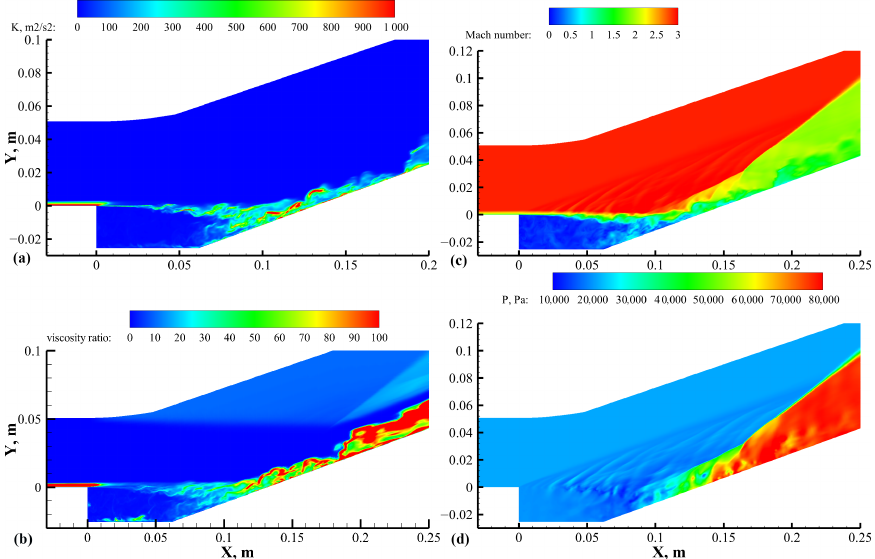
Figure 7. Contours of ( a ) turbulent kinetic energy, ( b ) viscosity ratio, ( c ) Mach number, and ( d ) static pressure from the IDDES